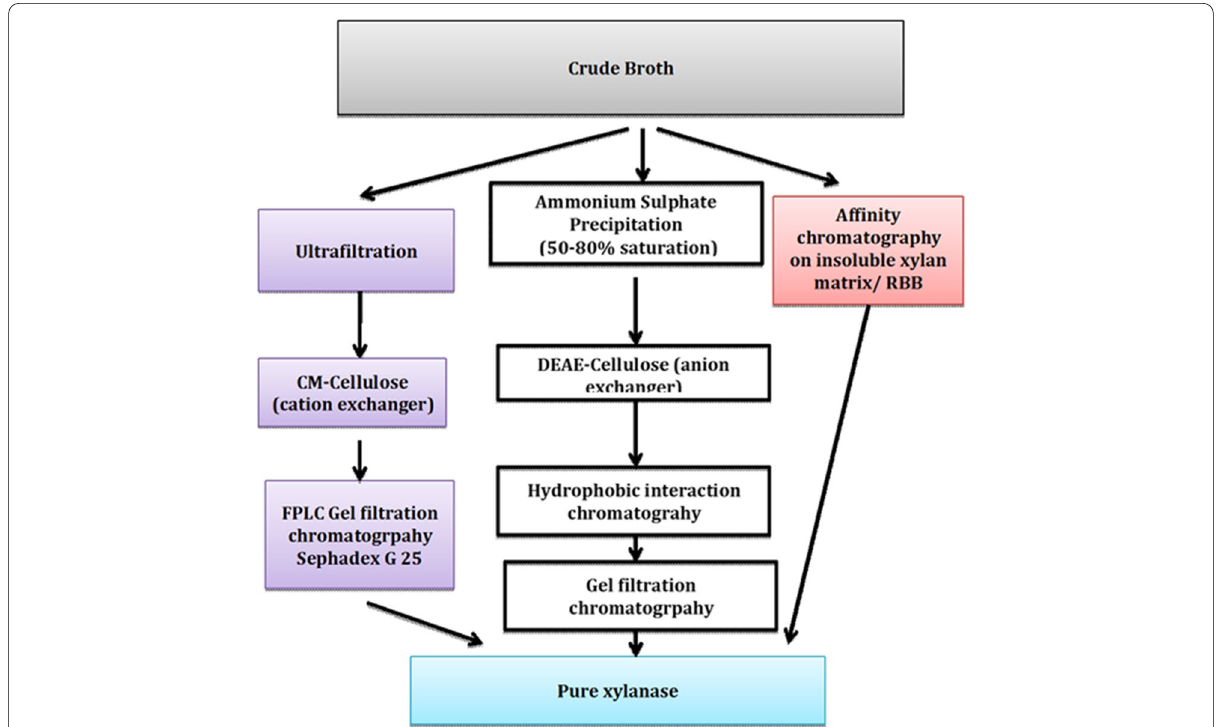
Fig. 1 Xylanase purification strategies employed by various